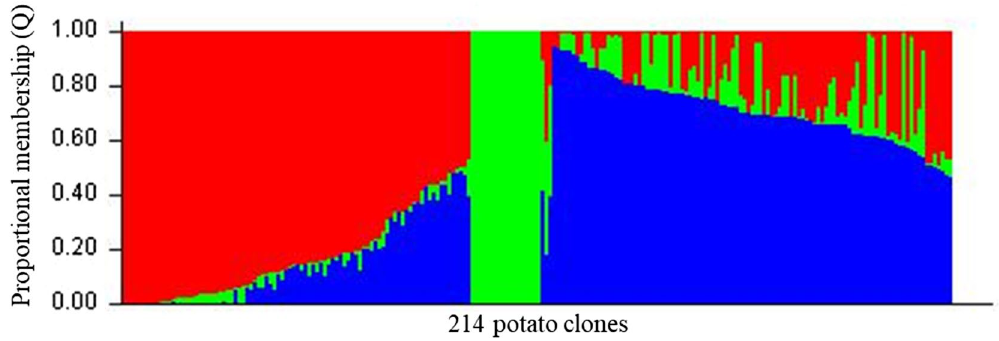
Figure 4. Proportional membership (Q) of each clone in the genetic clusters inferred by STRU CTU RE (K = 3). This figure represents each individual as a vertical bar and its membership probability in each subpopulation. Individuals with the highest proportion of membership to a subpopulation 1 (red color) corresponded to clones with red, purple, and yellow skin; Individuals belonging mainly to subpopulation 2 (green) include Russet Norkotah strain selections, and; Individuals with predominate membership to subpopulation 3 (blue) were russet and chipping